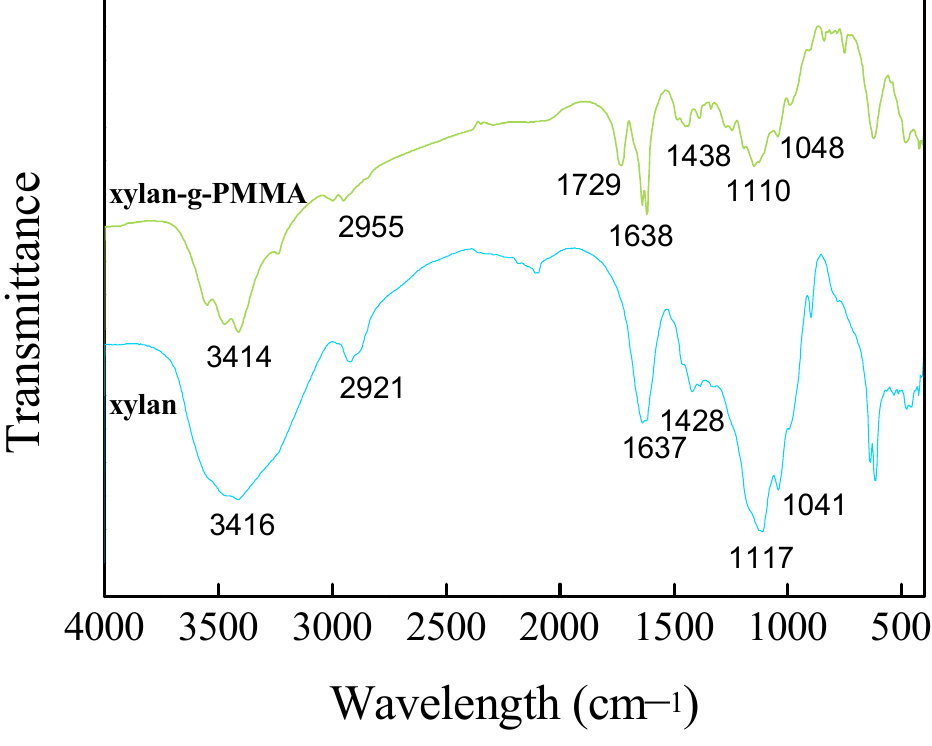
Figure 1. FT-IR spectra of xylan and xylan-g-PMMA.